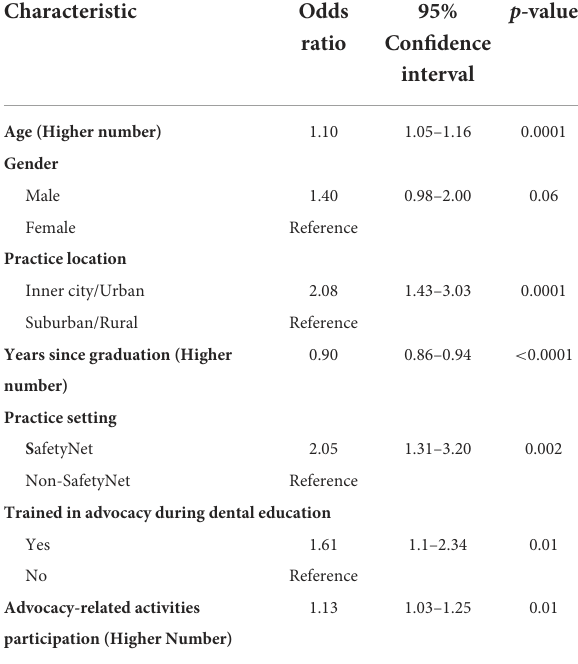
TABLE 3 Multivariable logistic regression results showing pediatric dentists’ acceptance of new Medicaid-children every month in clinical